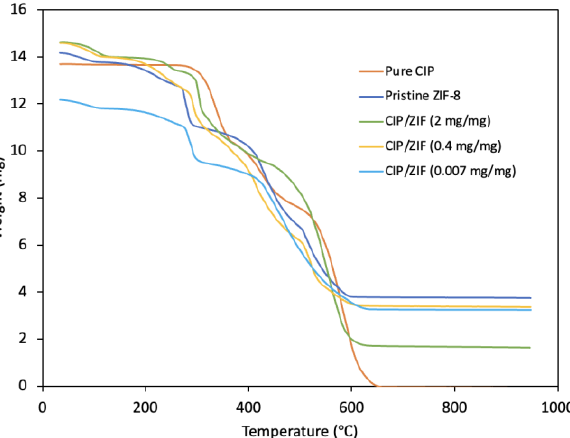
Figure 6. Thermogravimetric analysis of pure CIP, pure ZIF-8, and CIP/ZIF-8 with low, medium, and high drug loads. high drug